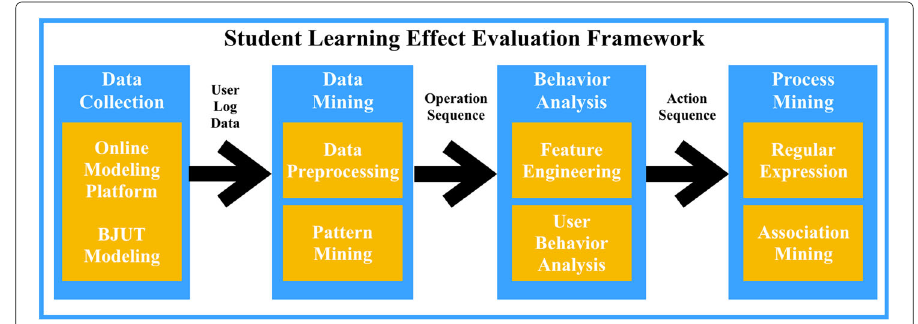
Fig. 1 Student learning effect evaluation